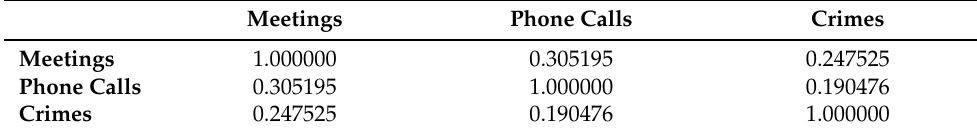
Table 5. Jaccard overlapping of the actors in the Montagna multiplex network.